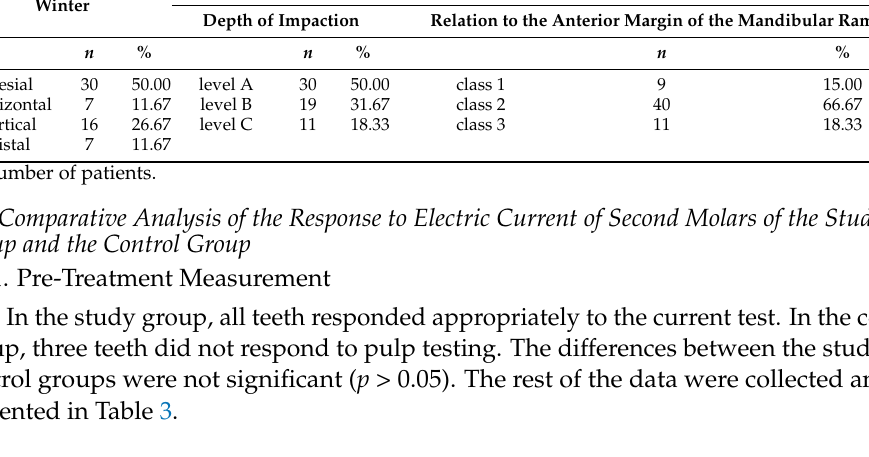
Table 3. Comparison of tooth excitability responses of the test group and the control group be- fore